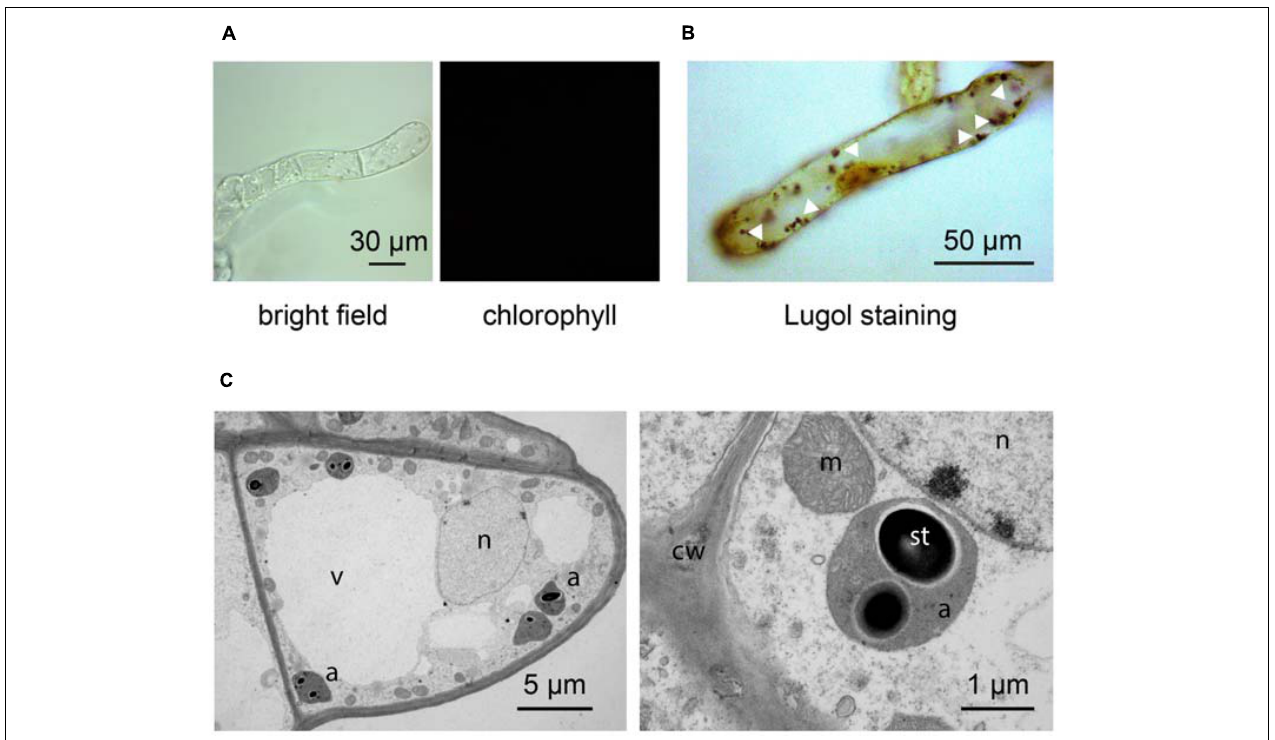
FIGURE 6 | Set up of Arabidopsis heterotrophic cell suspension culture, starting from the previously established photosynthetic culture. (A,B) Light microscopy observations of suspension-cultured cells, demonstrating the lack of any chlorophyll fluorescence signal (A) , as well as the presence of evident Lugol-stained starch granules (white arrowheads) (B) . (C) Ultrastructure of amyloplast-containing suspension-cultured cells. a, amyloplasts; cw, cell wall; m, mitochondria; n, nucleus; st, starch; v,